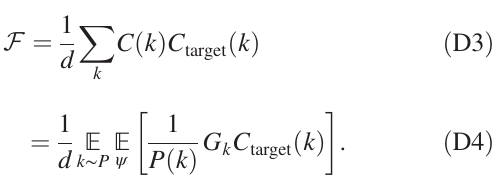
ffiffiffiffi p H gate on